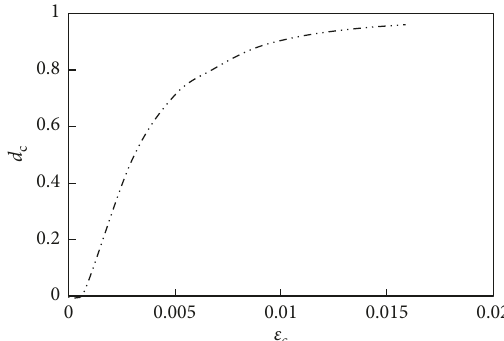
Figure 7: Relation curve of compression damage coefficient of